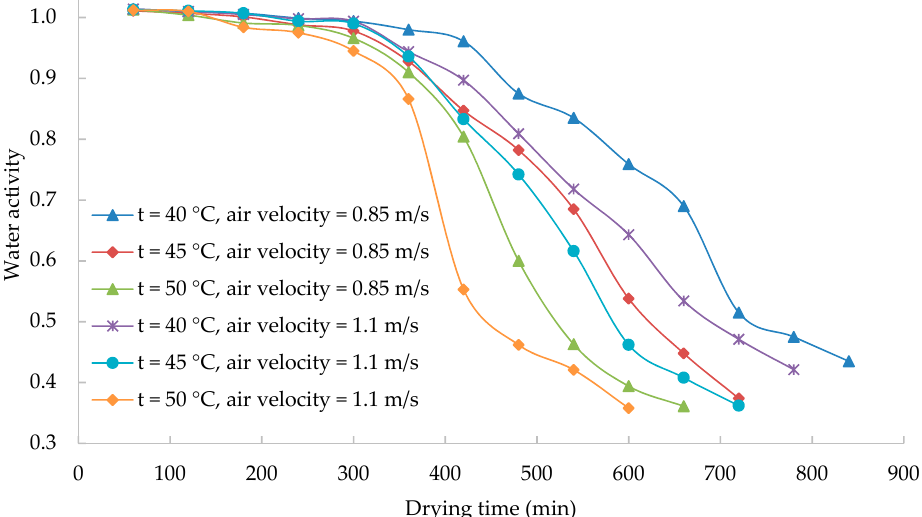
Figure 10. Variation of water activity versus drying time at different temperatures and air velocities.